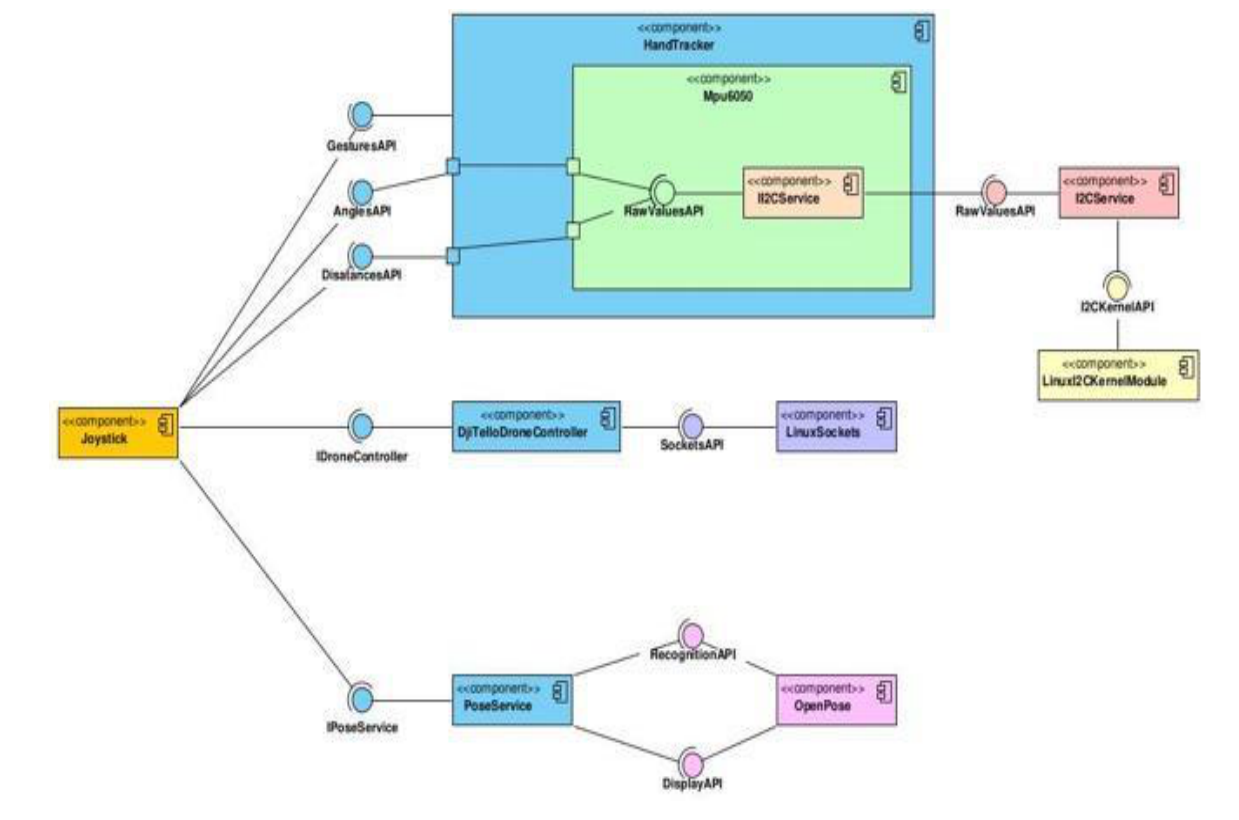
Figure 13. The Component Diagram of the principal services and modules of the PoC application.